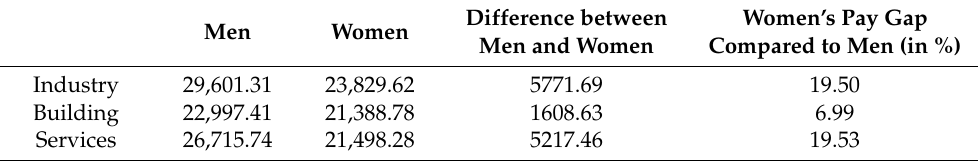
Source: Authors with data corresponding to 2019 provided by the Statistics National Institute ( Instituto Nacional de Estad í stica . Note: To calculate the women’s pay gap, we have applied the following formula: (average annual salary for men—average annual salary for women): average annual salary for men ×